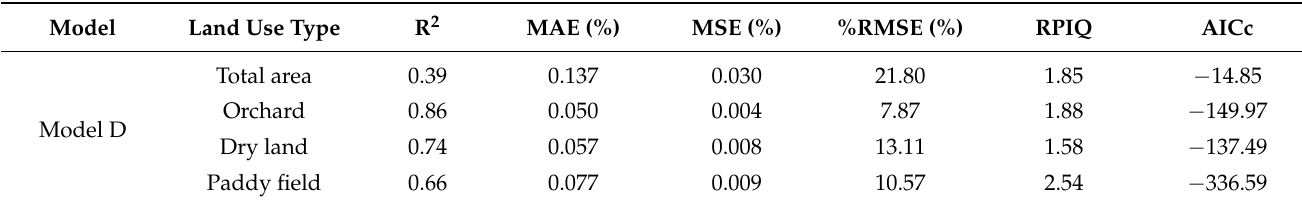
Table 4. Prediction accuracy of Model D with the selected features from DEM, Sentinel-1, and Sentinel-2 under total area, orchard, dry land, and paddy